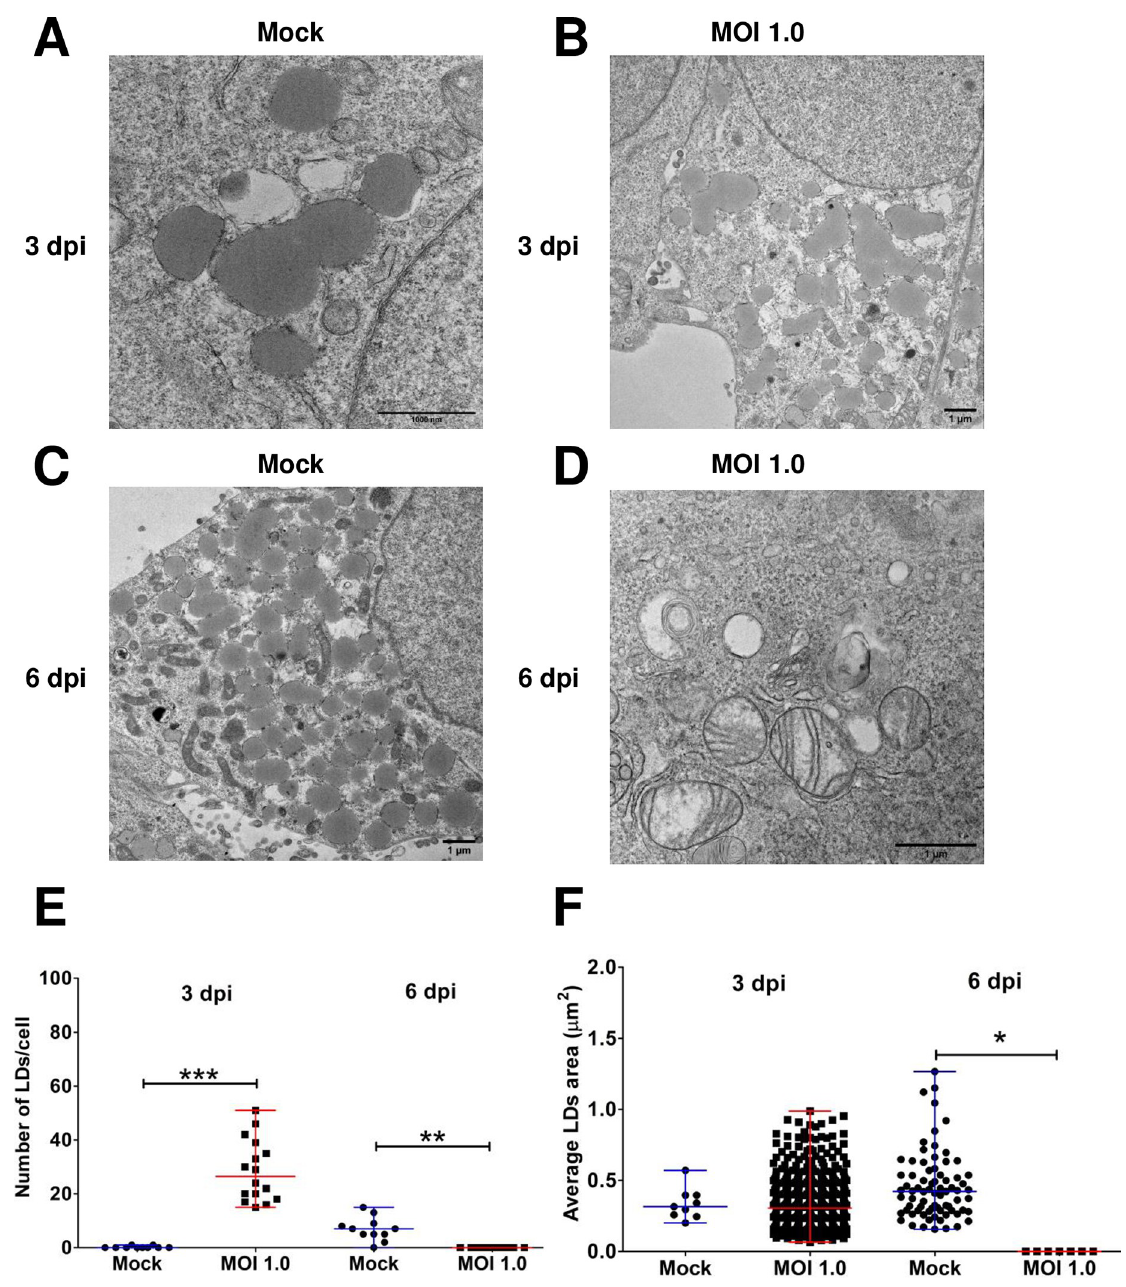
Fig 8. ZIKV infection in astrocytes-hNS1 causes changes in lipid droplets (LDs). The astrocyte-hNS1 culture was infected with ZIKV (MOI of 1) or mock-infected. At 3 and 6 dpi, the monolayers were fixed and processed for observation by transmission electron microscopy. (A) Mock-infected cells at three dpi. (B) Mock-infected cells at six dpi respectively, LDs can be observed in the cell’s cytoplasm. (C) ZIKV-infected cells (MOI of 1) at three dpi showed many LDs throughout the cytoplasm. (D) Representative micrograph of a ZIKV- infected cell at six dpi showing abnormal mitochondria and a complete absence of LDs. (E) Quantitative analysis of the number of LDs /cells, median, and range are presented, ** p < 0.001, *** p < 0.0001, U Mann Whitney test. (F) Quantitative analysis of LDs size (area, μ m 2 ), the mean and standard deviation are presented, p = 0.10, Kruskal Wallis test, comparisons between the groups where measurements of LDs area could be determined.